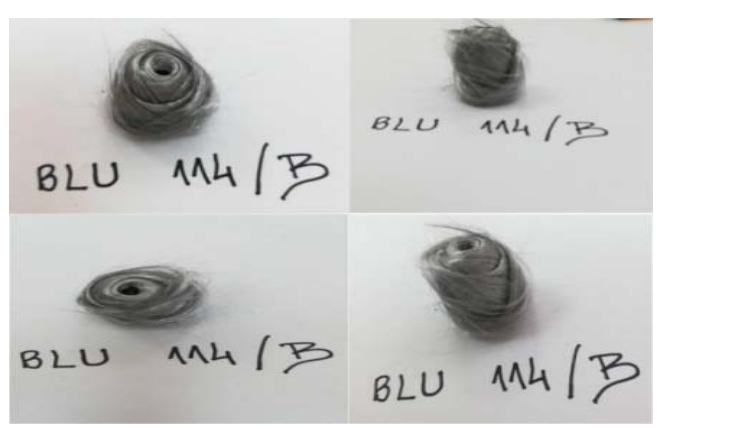
Figure 6 – Samples for the analysis – a separate spool of fibers from a cluster bomblet (Serbian Armed Forces, 1999)